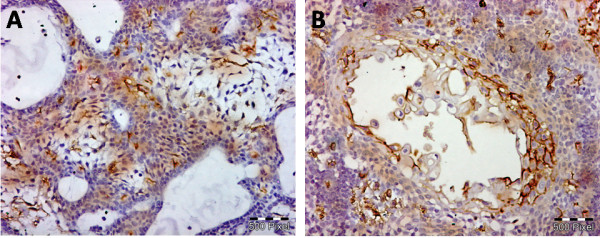
EGFR immunostaining (A) represents membranous and cytoplasmic EGFR expression in basal and stellate reticulum like cells. (B) represents membranous and cytoplasmic EGFR expression in focus of squamous differentiation (immunoperoxidase X200).